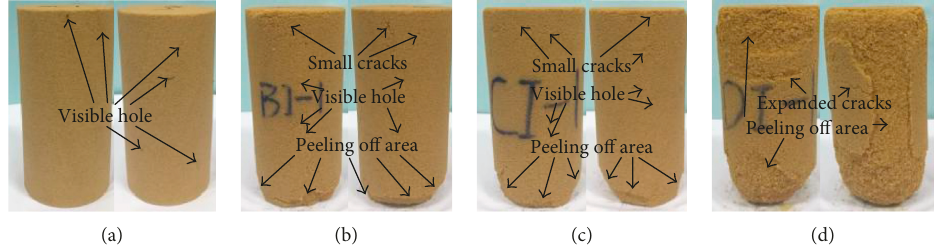
Figure 3: Figures of rock samples immersed in solution with pH of 2.8 and underwent different F-Tcycles. (a) 10 cycles, (b) 20 cycles, (c) 30 cycles, and (d) 40